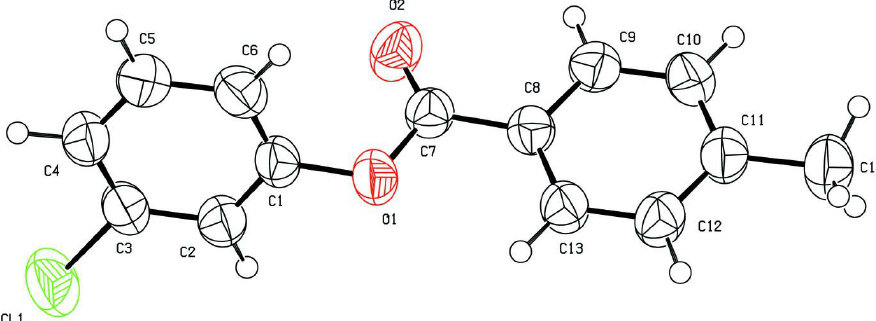
Molecular structure of the title compound, showing the atom labeling. Displacement ellipsoids are drawn at the 50% probability level. H atoms are represented as small spheres of arbitrary